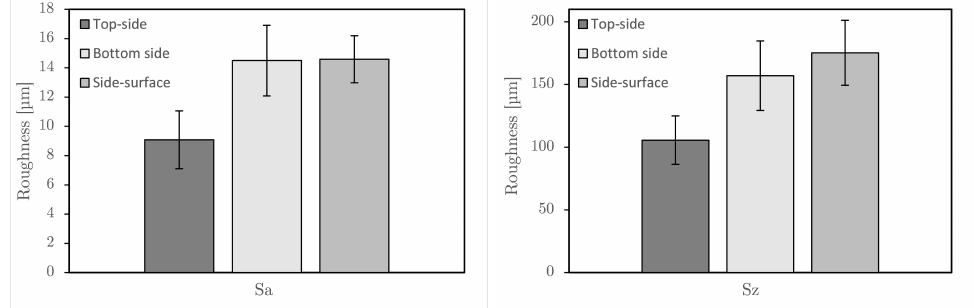
Figure 12. Surface roughness characteristics Sa and Sz for the three main printing